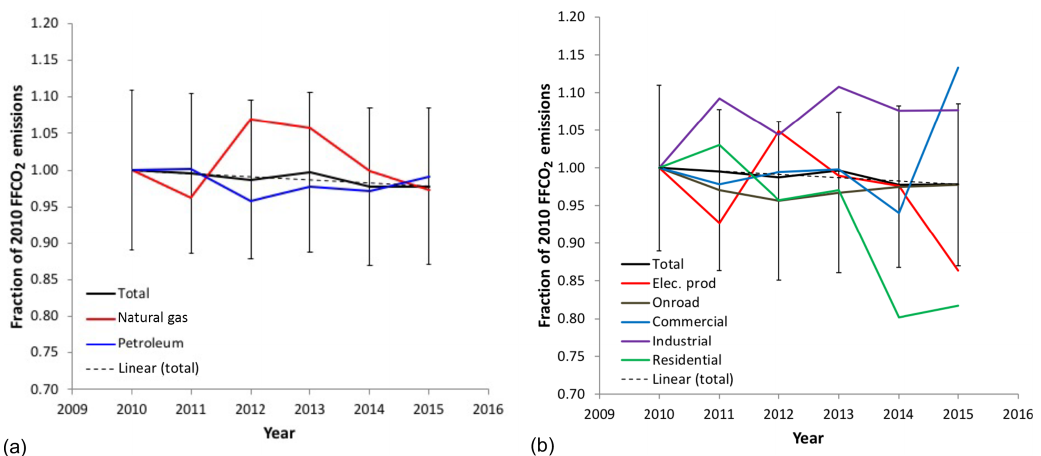
Figure 10. Fractional changes over the 2010 to 2015 timeframe in LA Basin FFCO 2 emissions: (a) by fuel category and (b) by sector. Whole-city error is provided for the total FFCO 2 emissions only.